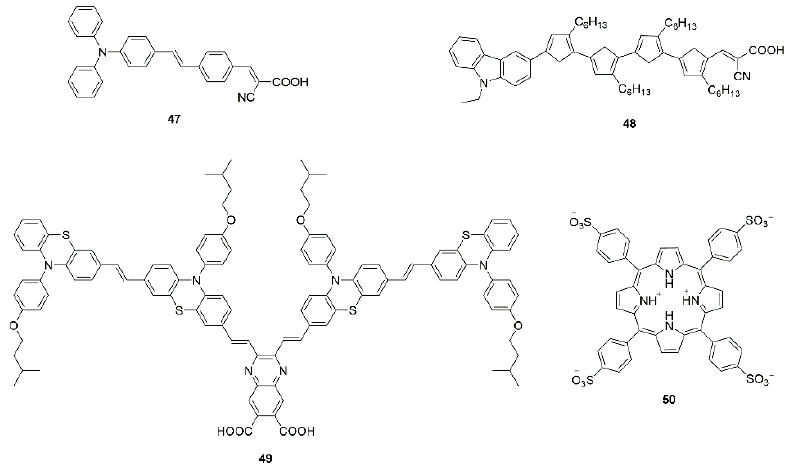
Figure 10. Chemical structures of dyes 47 – 50 .